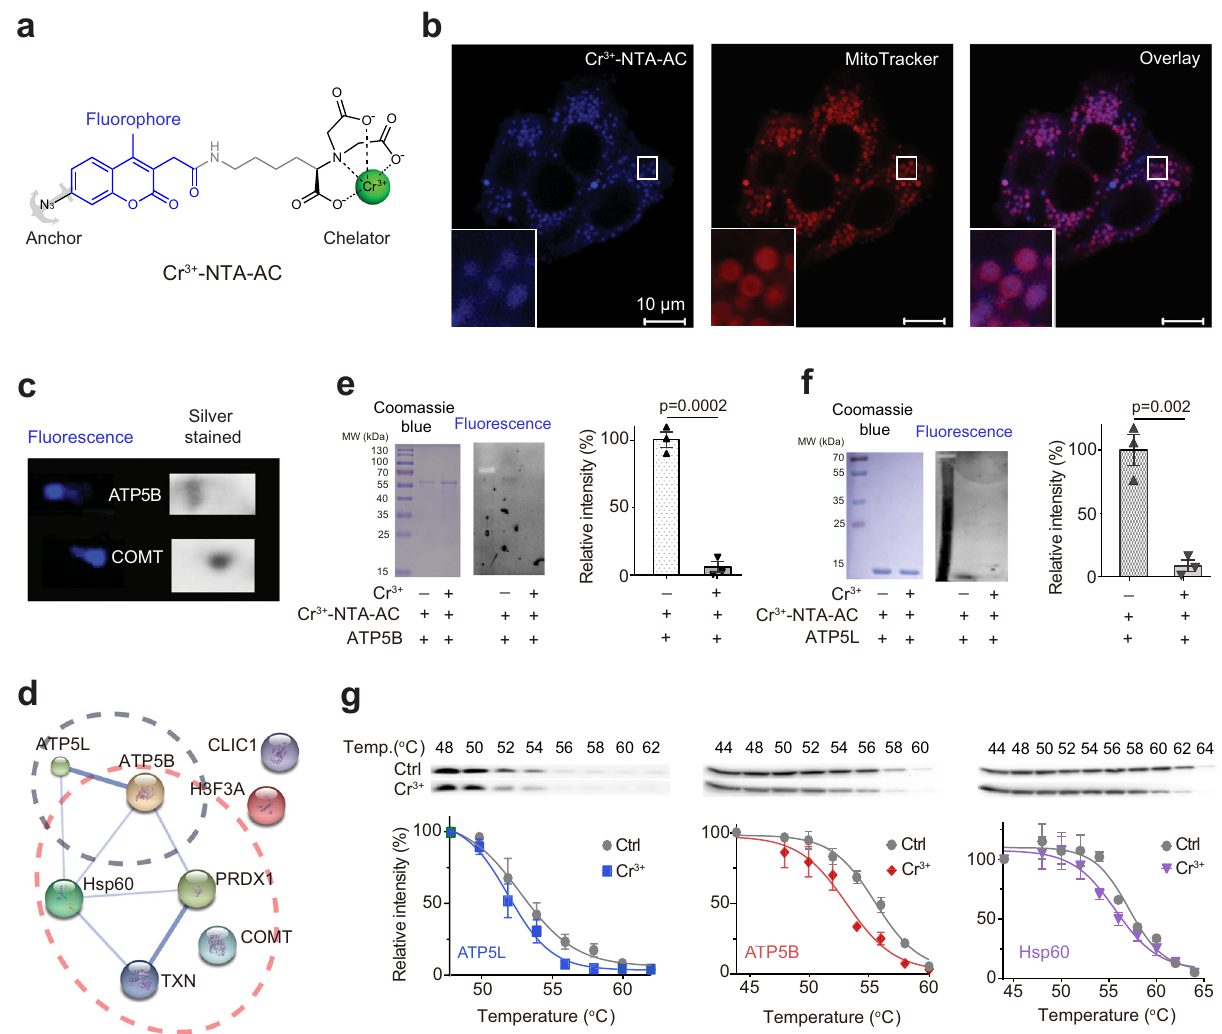
Fig.1|MiningCr 3+ -associatedtargetsthrough fl uorescentlabelling.a Structure ofCr 3+ -NTA-AC. b RepresentativeconfocalmicroscopicimagingofliveHepG2cells under high glucose stress (40mM) labelled with 50 μ M Cr 3+ -NTA-AC and Mito- Tracker red ( n =5), demonstrating that most of the blue signals localized in mito- chondria. Scale bar: 10 μ m. c Selected Cr 3+ -associated proteins in HepG2 cells identi fi ed in 2-DE by fl uorescence imaging and silver staining. Full 2-DE images are shown in Supplementary Fig. 2. d The protein-protein interaction (PPI) network of identi fi ed Cr 3+ -associated proteins in HepG2 cells generated via STRING 26 . The PPI